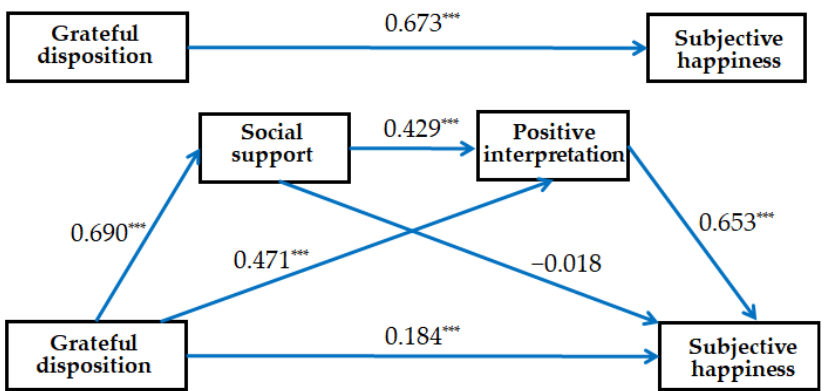
Figure 2. Examined double mediation model of social support and positive interpretation on grateful disposition and subjective happiness ( β , standardized coefficients; *** p < 0.001).